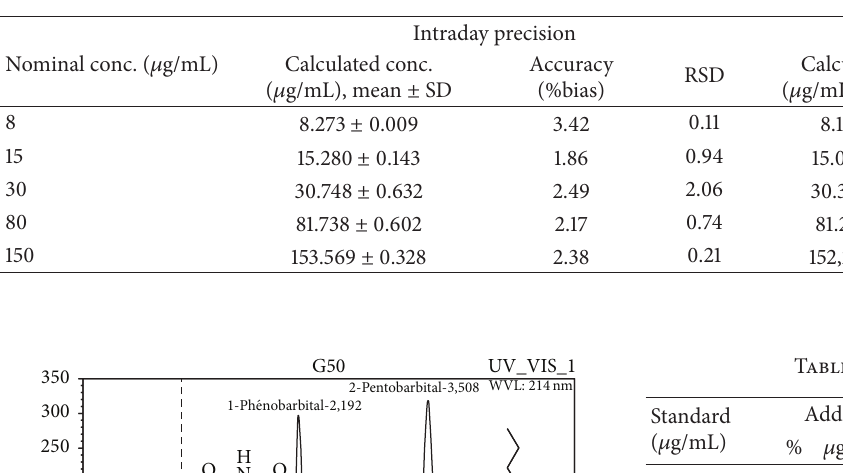
Table 4: Precision study of the method.